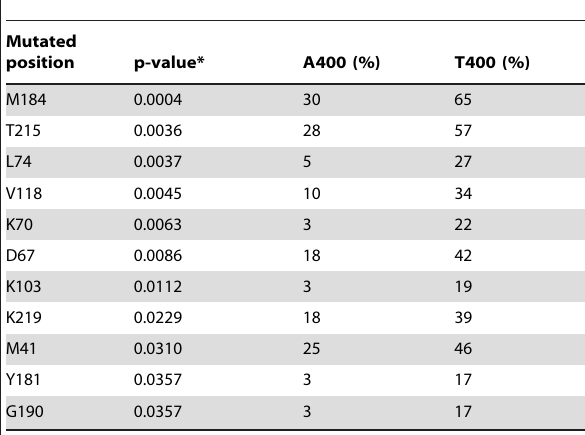
Table 2. Association between position 400 (alanine vs threonine) and polymerase domain mutations in subtype B viruses from patients failing